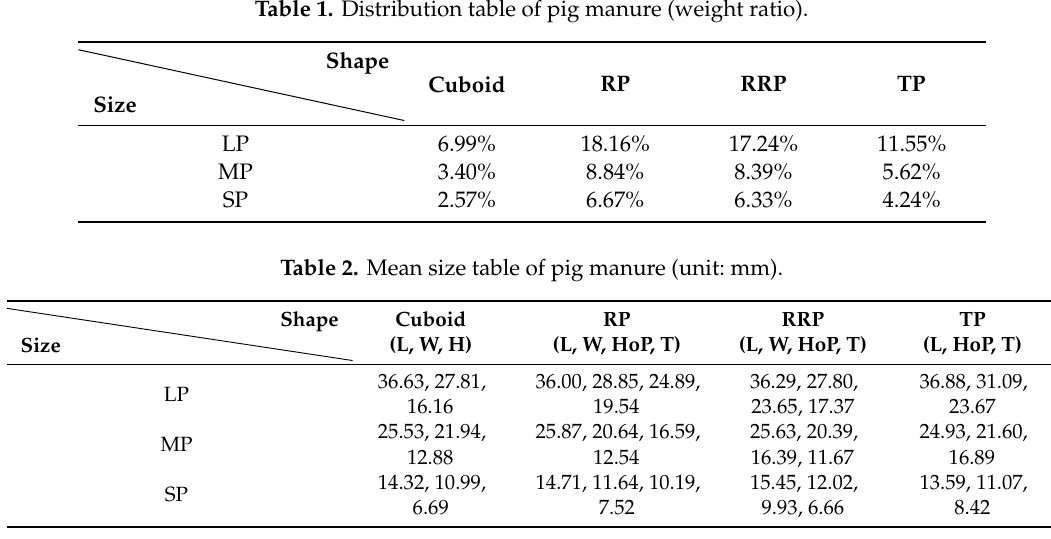
Table 2. Mean size table of pig manure (unit: mm).